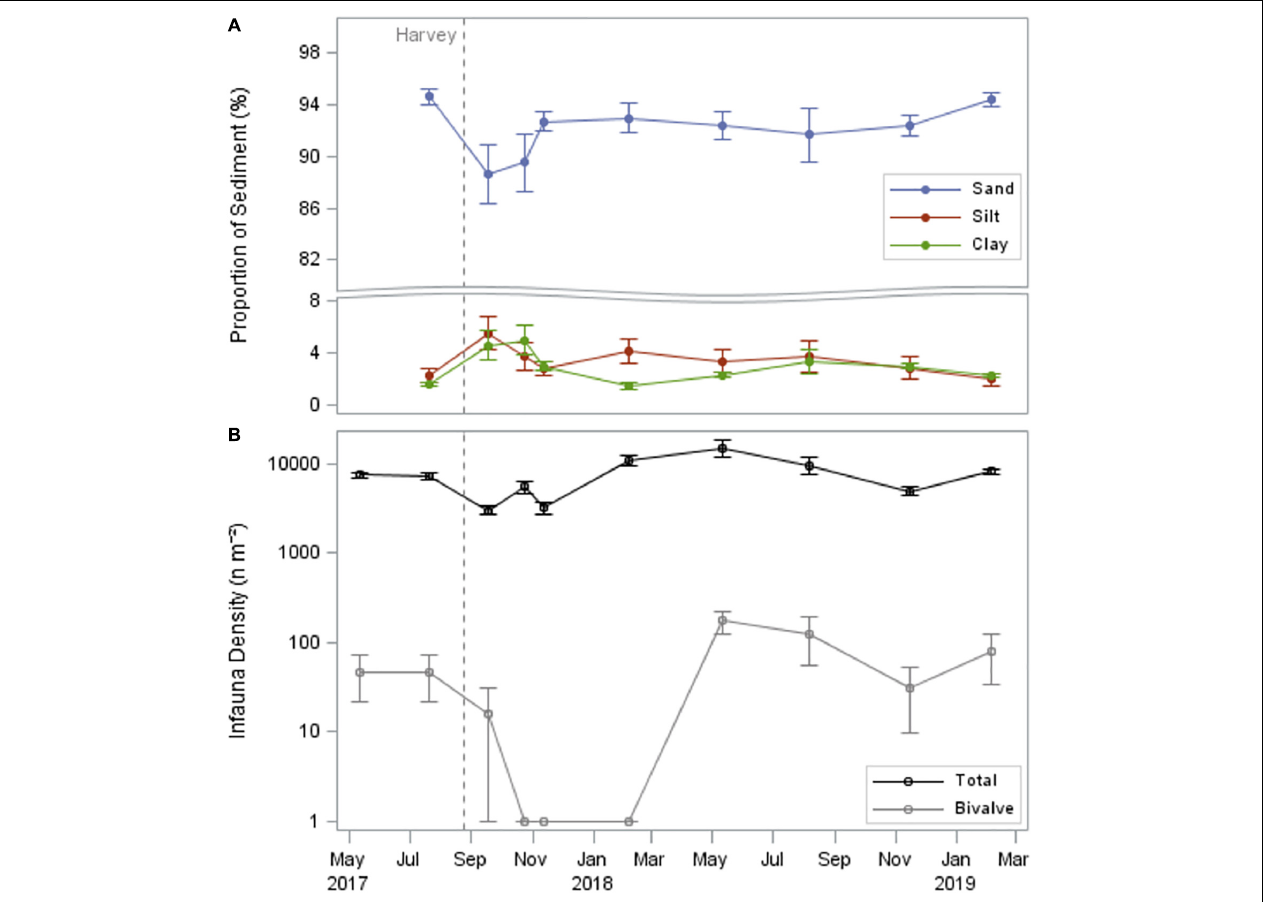
FIGURE 4 | Sediment grain size distribution (%; A ; note axis break), and mean density of infauna and bivalves (n m – 2 ; B ; note log-scale). Hurricane Harvey indicated by vertical dashed